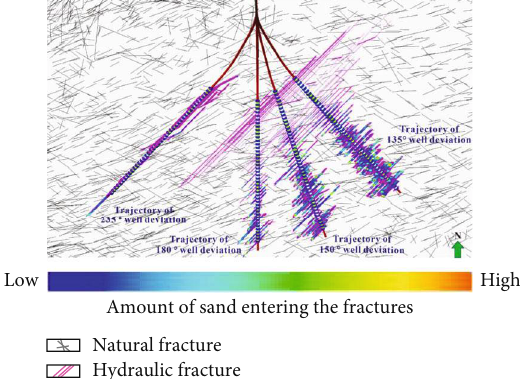
Natural fracture Figure 15: Hydraulic fracture network formed by fracturing in di ff erent drilling